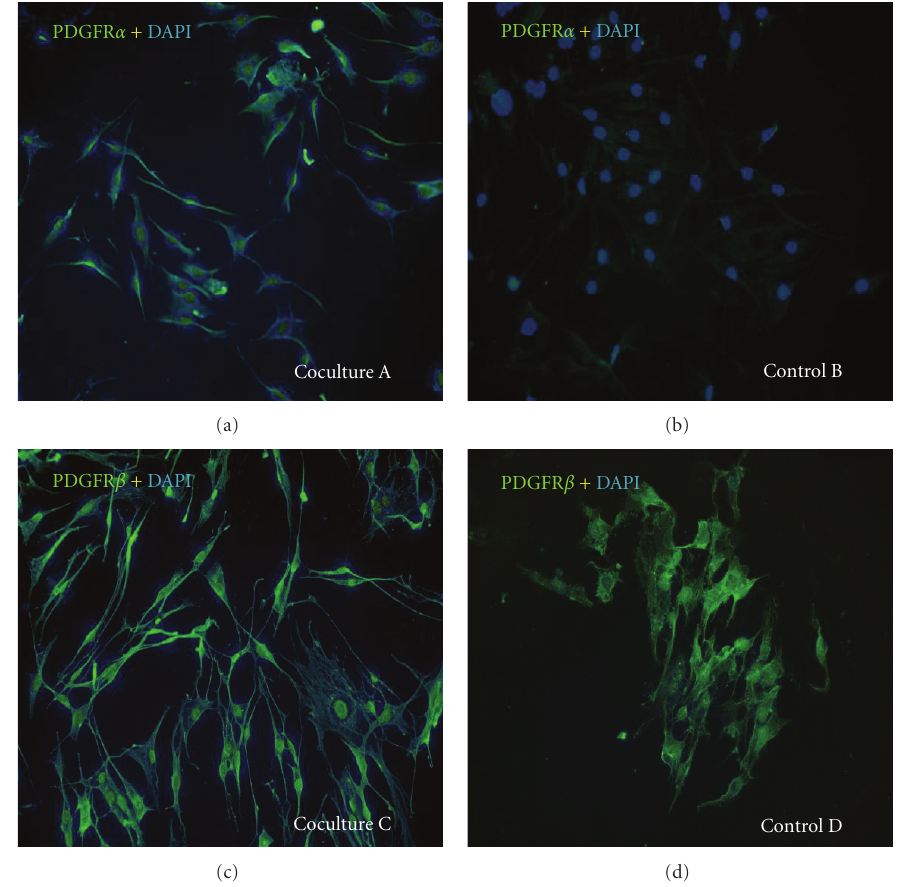
Figure 1: Immunocytochemical staining for PDGFR α and β (green) in MIO-M1 MPCs. Expression of PDGFR α after 5 days when cocultured with ARPE19 cells (A) and expression of PDGFR α in control culture (B). Expression of PDGFR β after 5 days when cocultured with ARPE19 cells (C) and expression of PDGFR β in control culture (D). PDGFR β expression appears relatively stable, while PDGFR α expression increases more